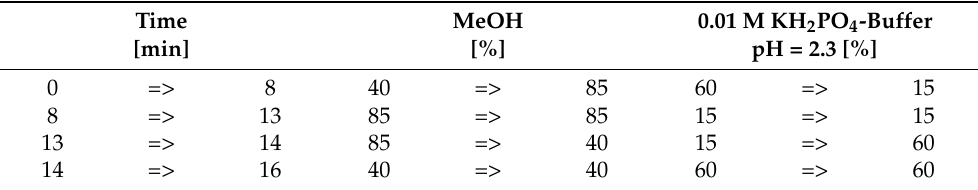
Table 2. Mobile phase gradient applied in high-performance liquid